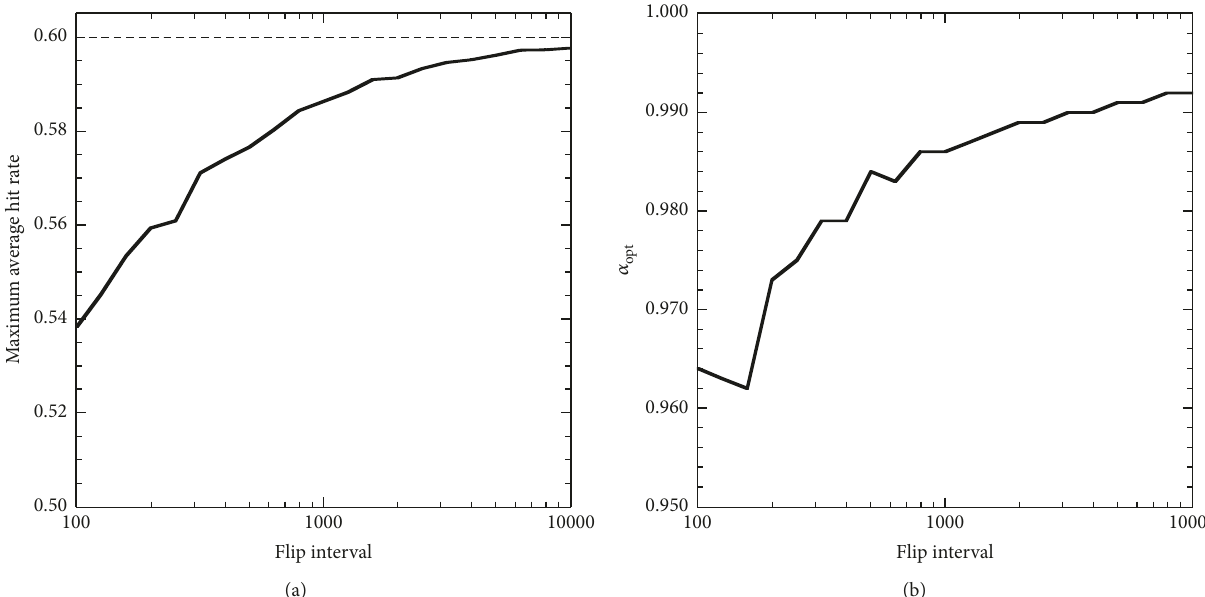
Figure 8: (a) Maximum average hit rate (AHR) and (b) the corresponding optimal memory parameter 𝛼 opt for different flip intervals. The upper limit of AHR is 0.6 (dashed lines).